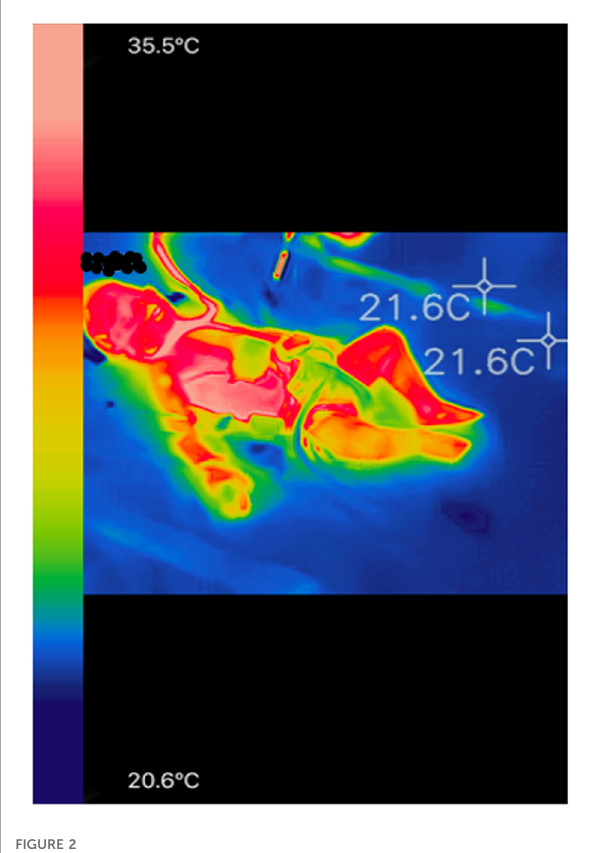
FIGURE 2 Example of a colored infrared image in a child undergoing postoperative cardiac surgery with the FLIR One Pro camera. Blue pixels correspond to the coldest temperatures and the pale pink pixels correspond to the warmest temperatures, as it is the case in front of the internal cantus of the eye and the thoracic